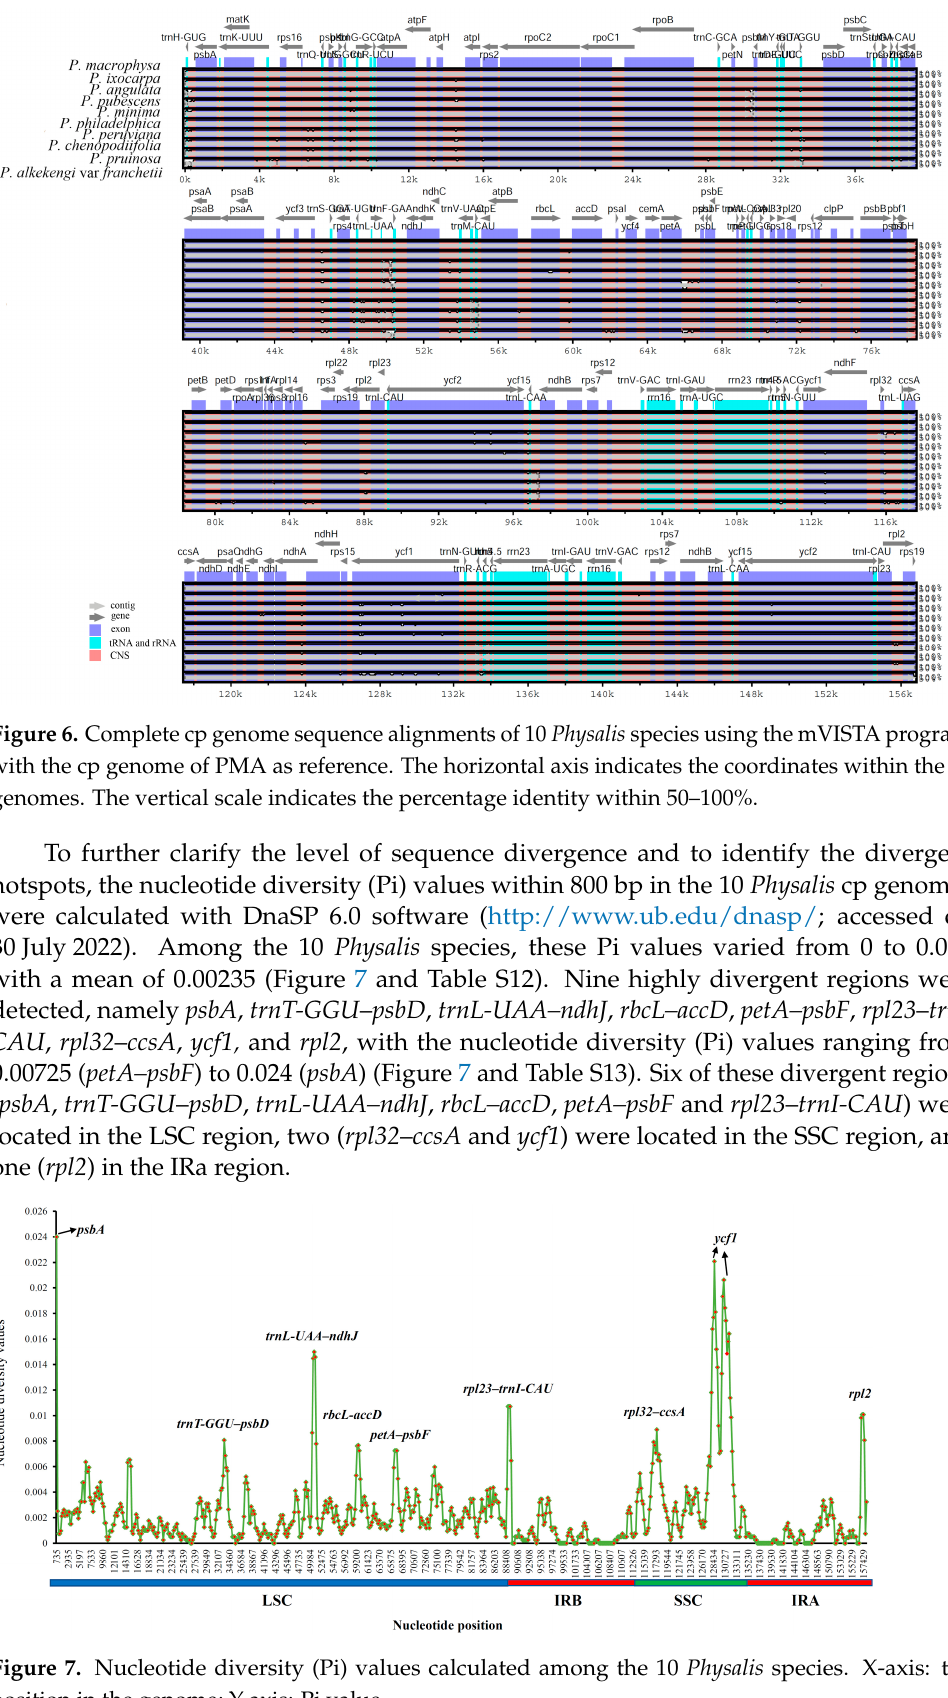
Figure 7. Nucleotide diversity (Pi) values calculated among the 10 Physalis species. X-axis: the position in the genome; Y-axis: Pi value.